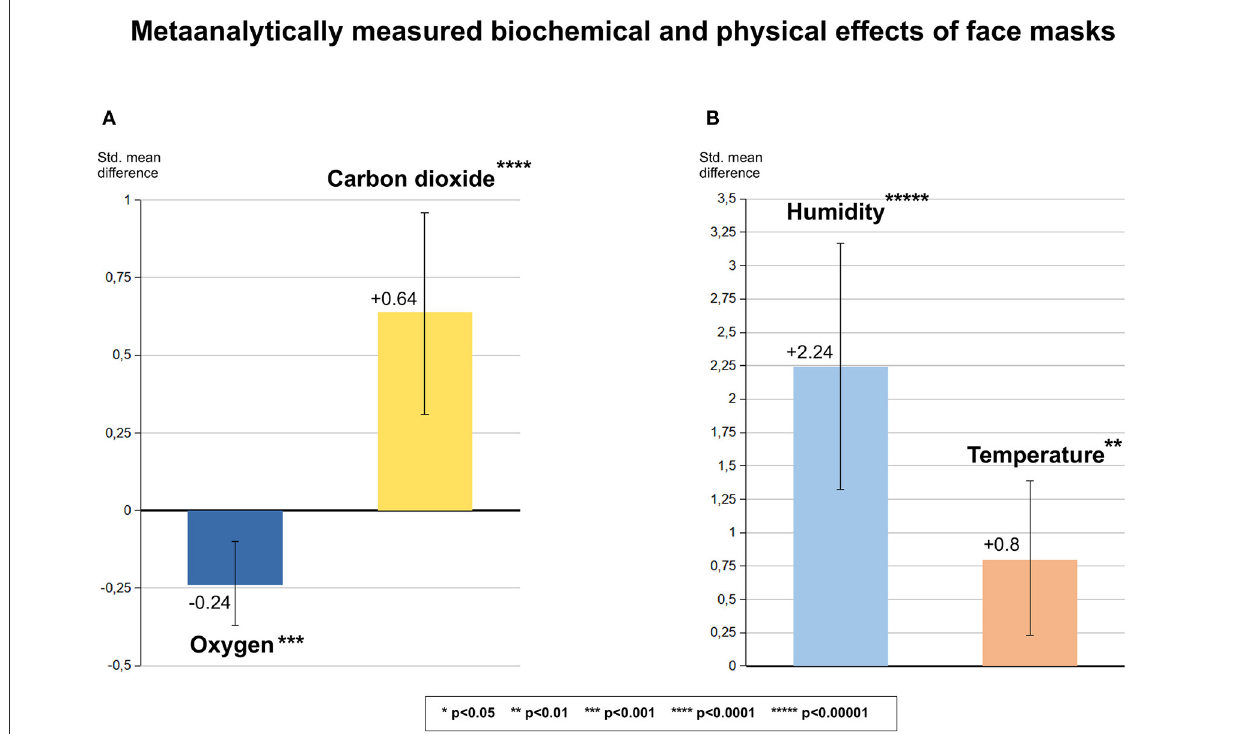
FIGURE9 Summary of pooled meta-analytic evaluation of biochemical (A) and physical effects (B) during face mask use. The height of the bars reflects the SMD (standard mean difference), their error bars correspond to the confidence intervals. (A) For carbon dioxide rise in the blood there is a medium effect size of > 0.5 and for oxygen drop a small effect size of > 0.2 regarding the standard mean difference values thresholds according to Cohen (102). (B) For elevated Humidity and Temperature rise under the face mask there is a strong effect size of 0.8. The meta-analytical statistical data ≥ were as follows: Oxygen (SpO 2 ): SMD 0.24, 95% CI 0.38 to 0.11, Z 3.53, p 0.0004; Carbon dioxide (PtCO 2 , ETCO 2 , and PaCO 2 ): SMD 0.64, − − − = = + 95% CI 0.31 to 0.96, Z 3.86, p 0.0001; Humidity: SMD 2.24, 95% CI 1.32 to 3.17, Z 4.75, p < 0.00001; Temperature: SMD 0.8, 95% CI 0.23 to = = + = + 1.38, Z 2.72, p = =